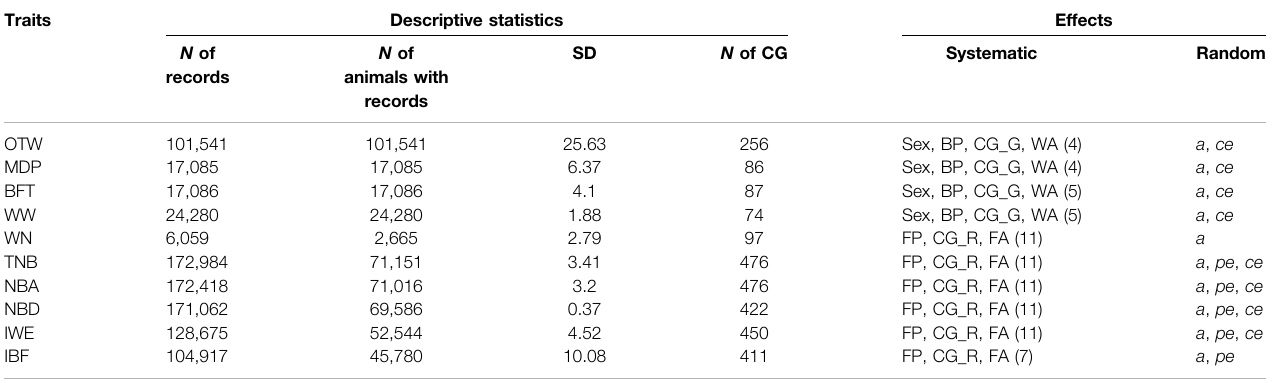
TABLE 2 | Descriptive statistics of phenotypes and effects used for each trait.